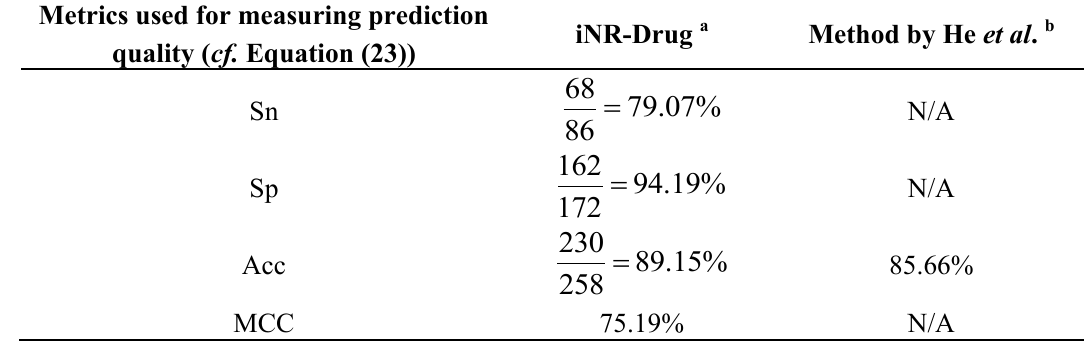
Table 1. The jackknife success rates obtained iNR-Drug in identifying the interactive NR-drug pairs and non-interactive NR-drug pairs for the benchmark dataset ( cf. Supplementary Information S1).